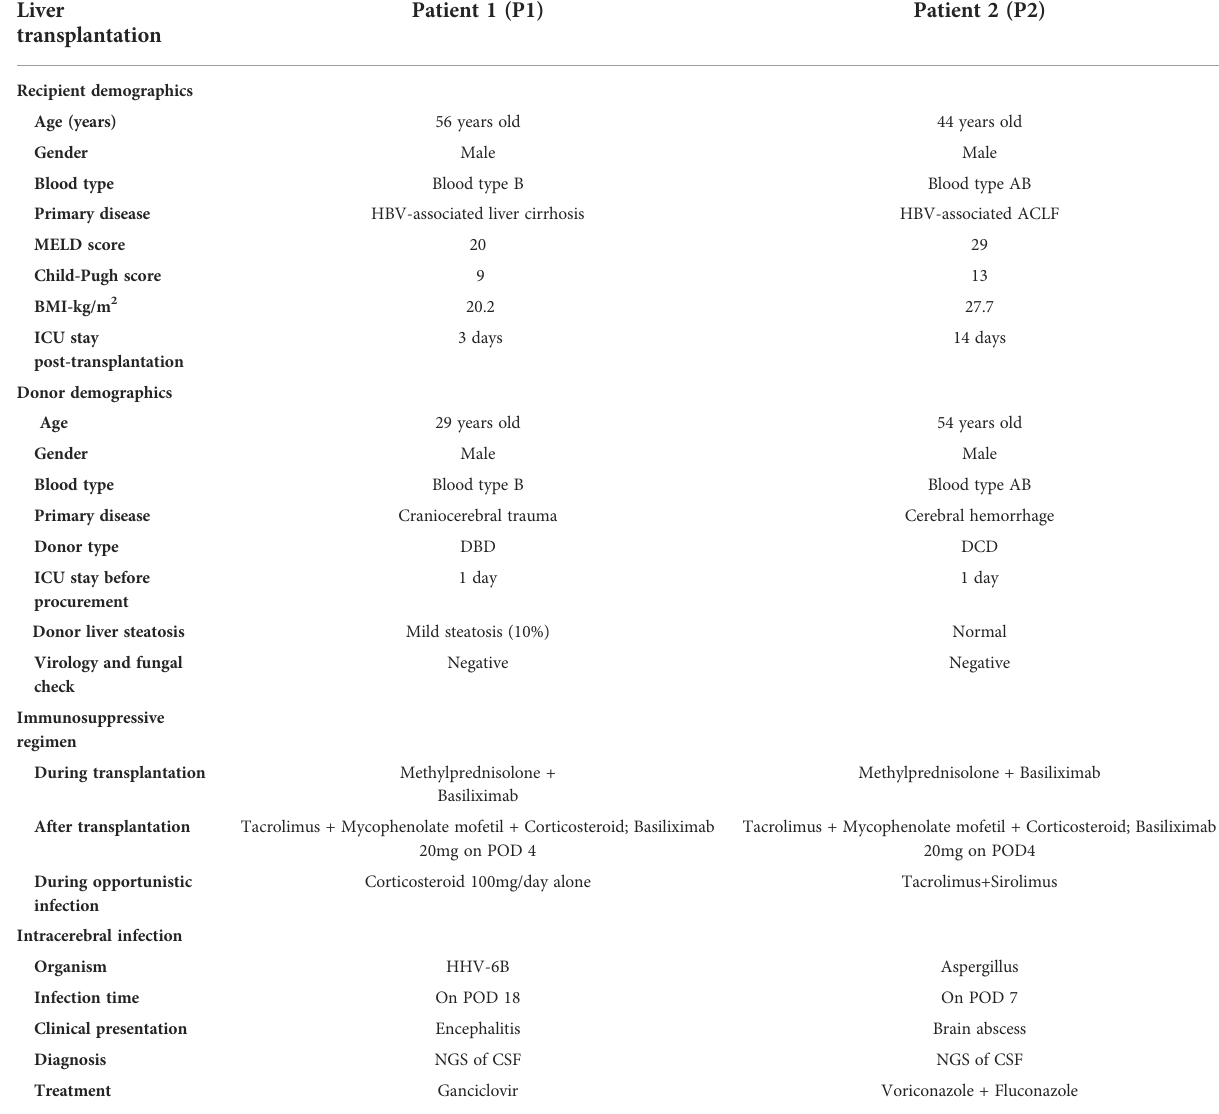
TABLE 1 Two cases of CNS opportunistic